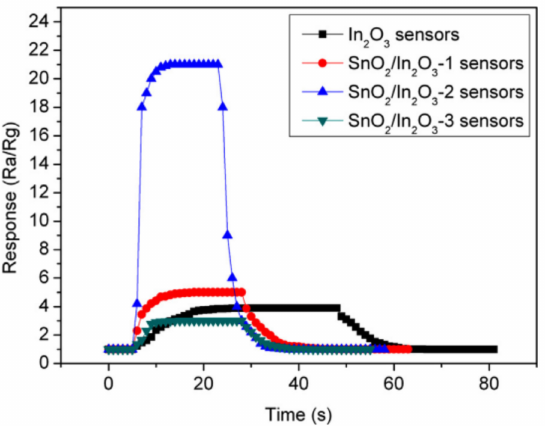
Figure 20. Response–time curves of In 2 O 3 nanofiber sensors decorated with SnO 2 to 1 ppm NH 3 at room temperature: SnO 2 /In 2 O 3 —1–7.5 at.% Sn; SnO 2 /In 2 O 3 —2–16 at.% Sn; and SnO 2 /In 2 O 3 —3–21 at.% Sn. Reprinted with permission from [261]. Copyright 2014